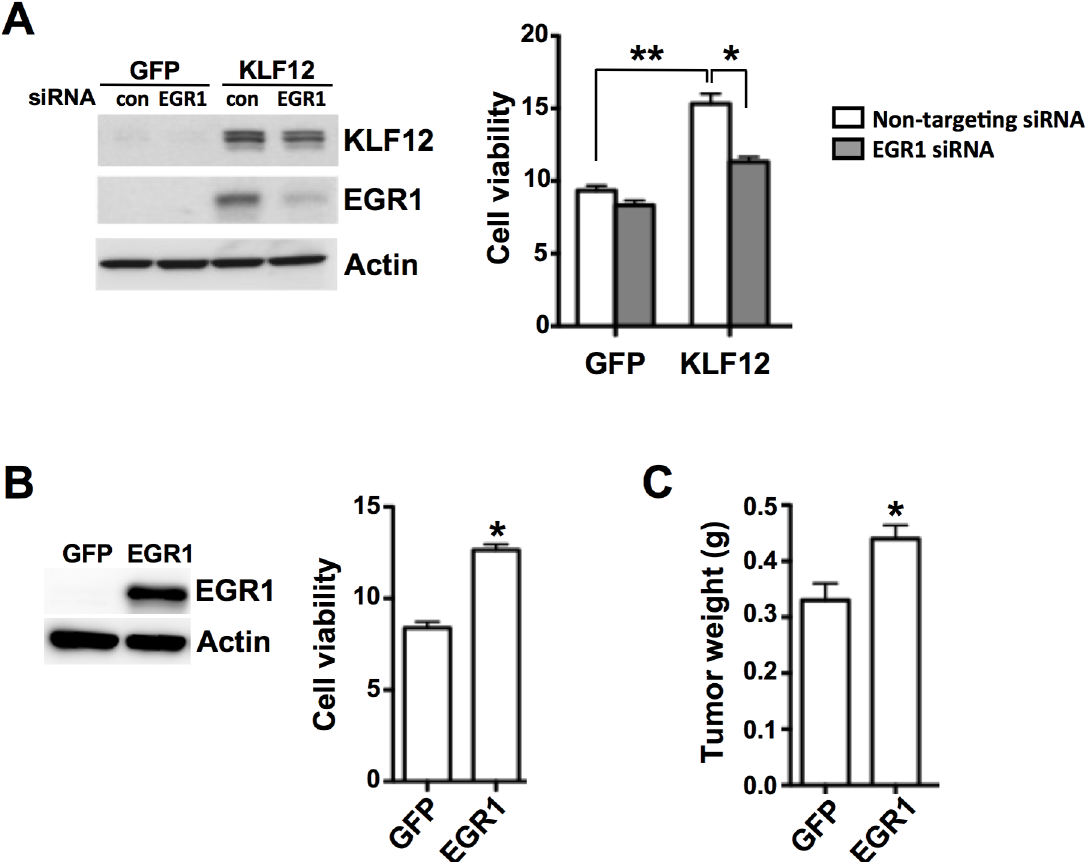
Fig 4. KLF12 enhances cell viability by activating EGR1. (A) Protein levels of KLF12 and EGR1 (left) and cell viability (right) of LS174T/GFP and LS174T/KLF12 cells transfected with either non-targeting siRNA as control (con) or EGR1 siRNA. Actin served as a loading control. (B) EGR1 protein levels (left) and cell viability (right) of LS174T cells transfected with either GFP (LS174T/GFP) or EGR1 (LS174T/EGR1). (C) Tumor weight in mice orthotopically injected with either LS174T/GFP or LS174T/EGR1 cells (n = 8 for each